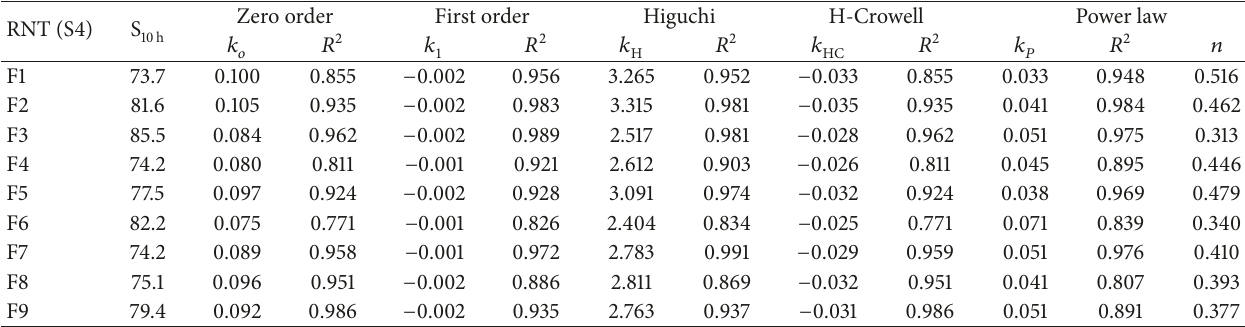
Table 9: DR study for 4th batch matrix